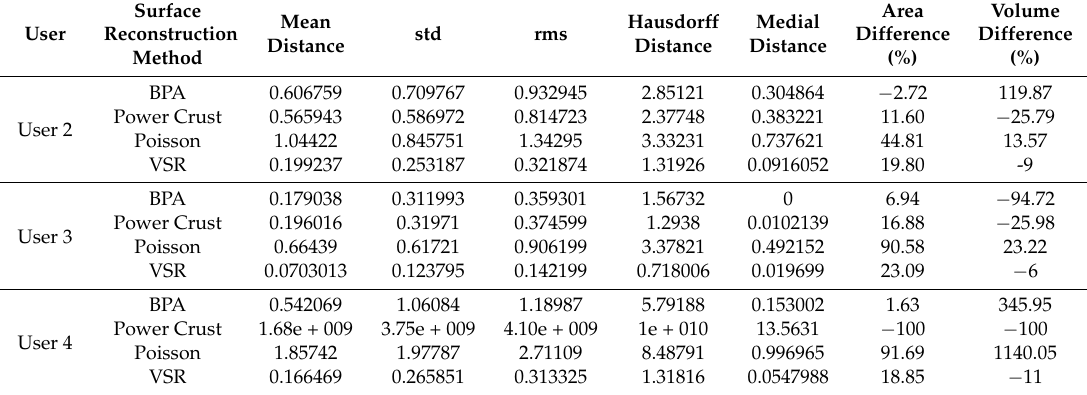
Figure 13. Hausdorff distances between the reconstructed surfaces from the contours drawn by Users 2, 3, and 4 and the reconstructed surface from the contours drawn by User 1 (LIVER TUMOR). The contours were drawn by four different users. Table 4. Difference between the reconstructed surfaces from the contours drawn by Users 2, 3, and 4 and the reconstructed surface from the contours drawn by User 1 (LIVER TUMOR).